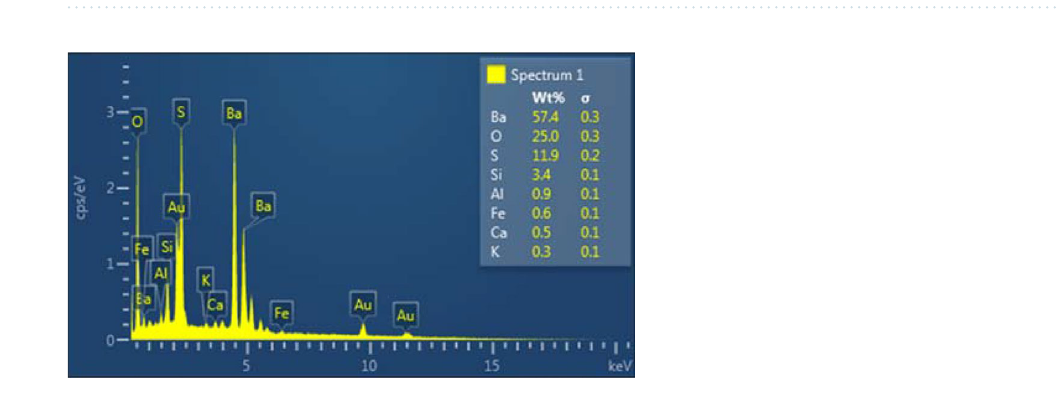
Figure 2. SEM–EDS of barite weighting agent.